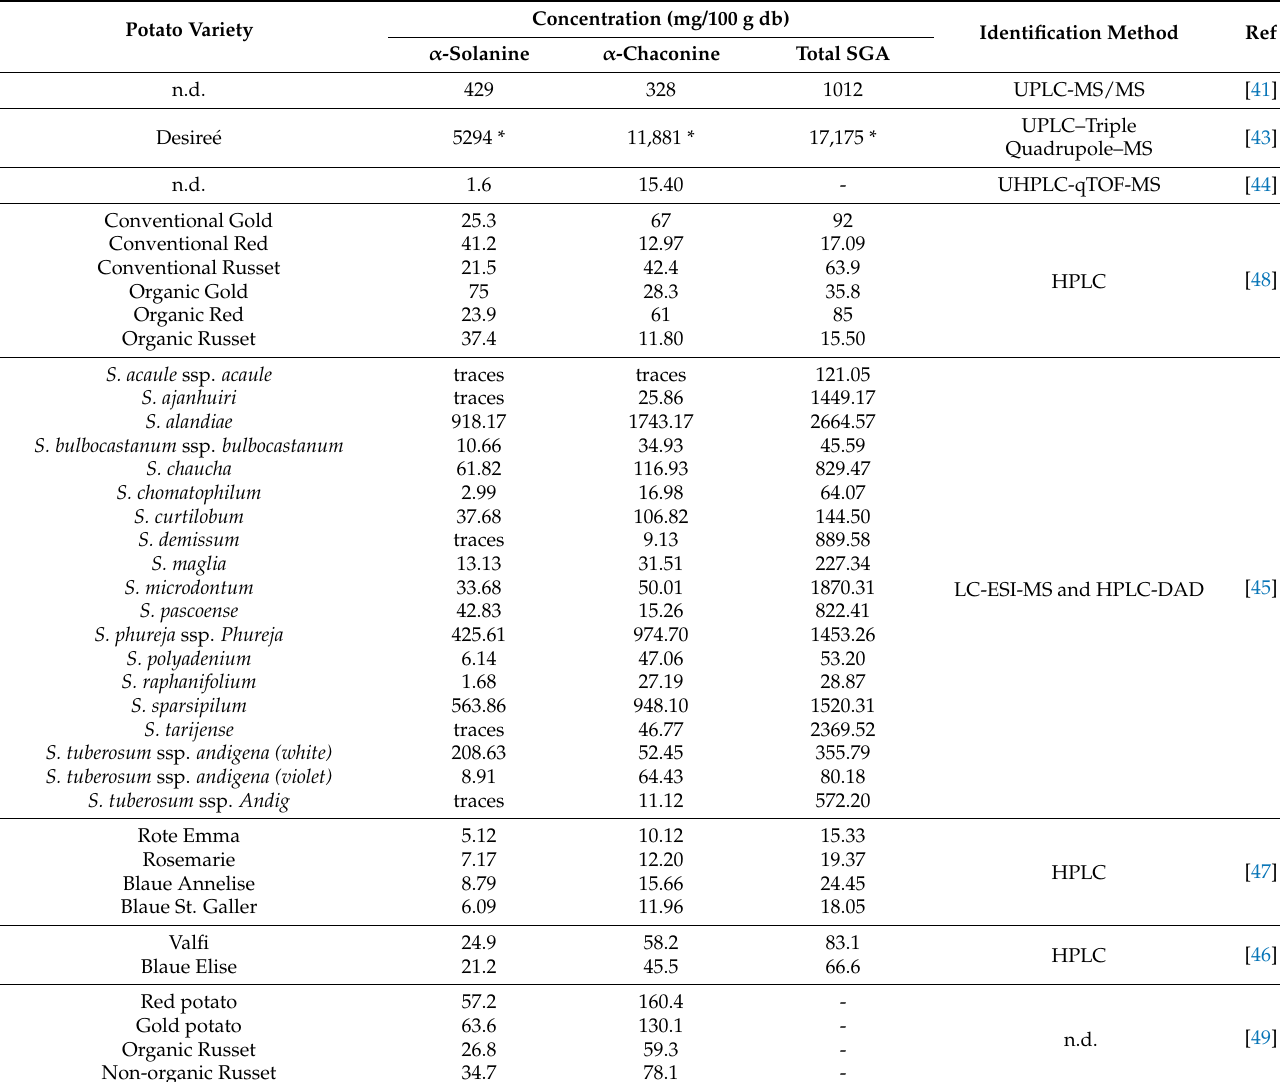
Table 2. Total glycoalkaloid content and the main glycoalkaloids detected in different potato peel varieties. Potato